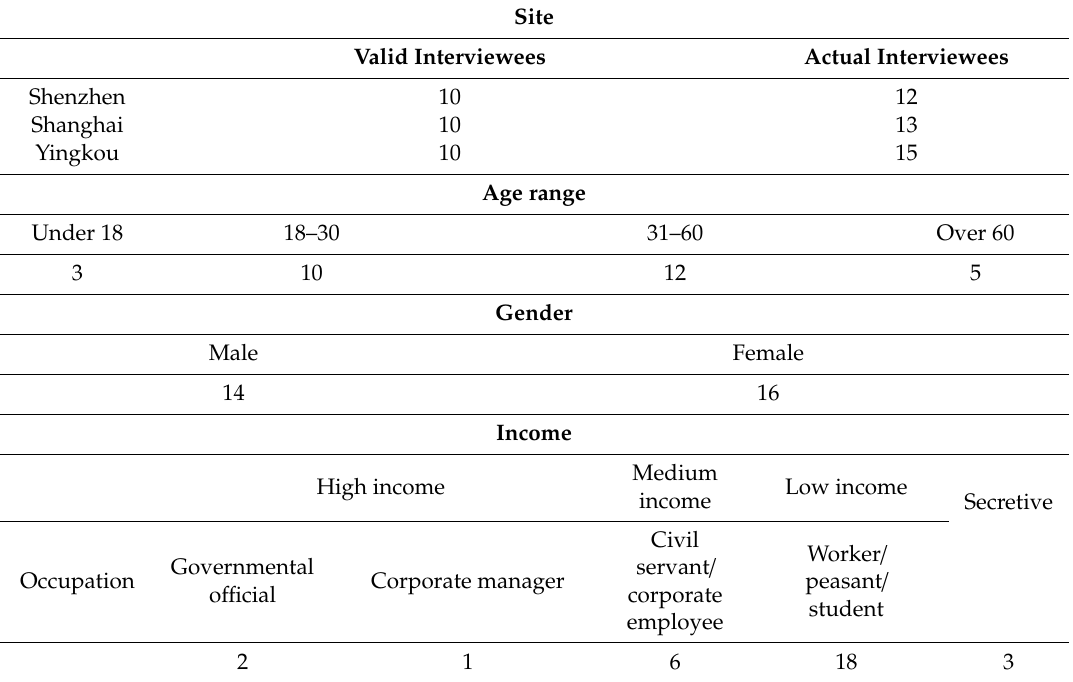
Table 1. The population demographics of